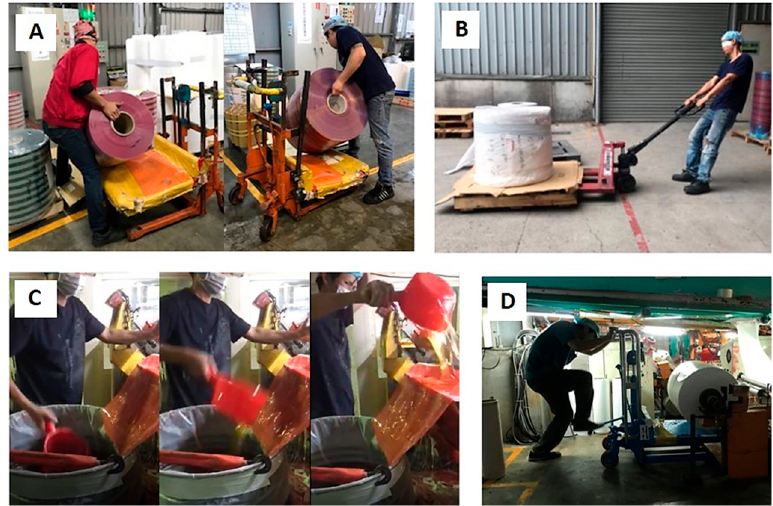
Figure 1. Four daily heavy-duty tasks performed during the tape manufacturing process: ( A ) low- ering of inventory; ( B ) pulling of raw material; ( C ) ladling of glue; and ( D ) feeding of material.